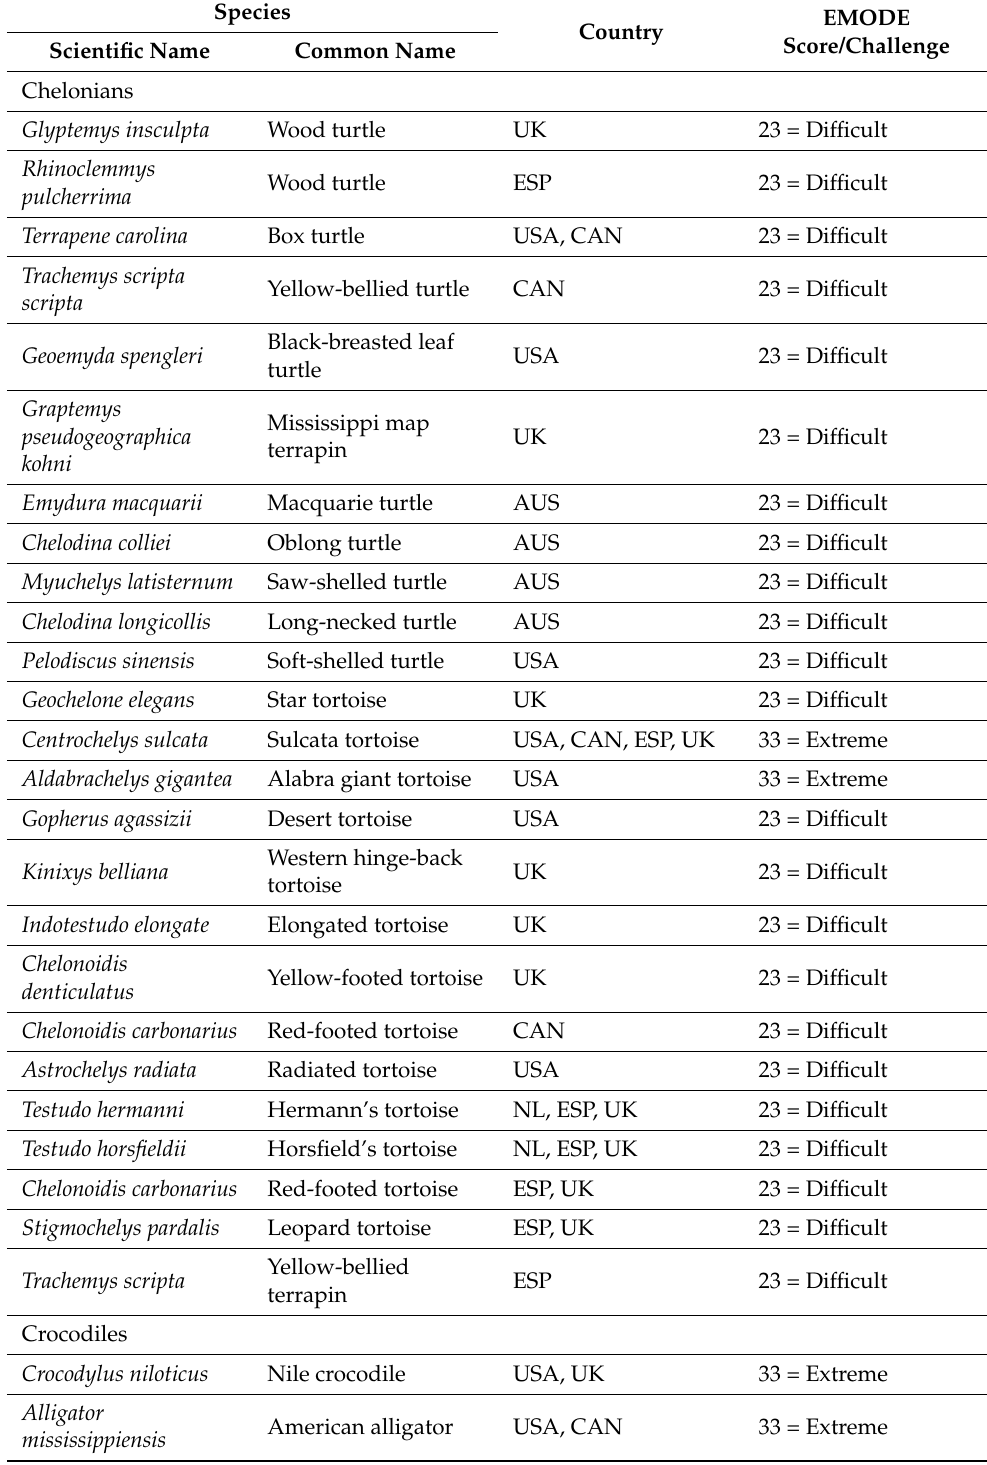
Table 6. Reptiles involved in handling and other practices at mobile zoos by species and country of where used, and their EMODE ‘suitability to keep’